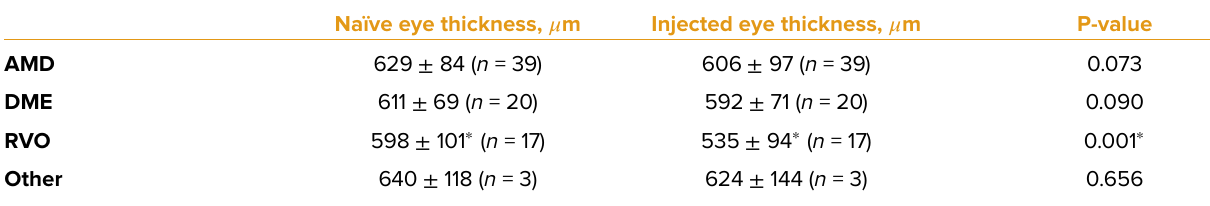
Table 4. Scleral thickness and IOP measurements as stratified by indication